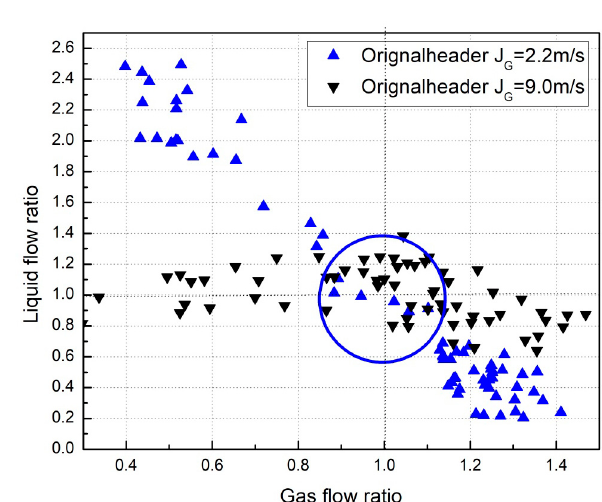
Figure 9. Top view of original intermediate header.